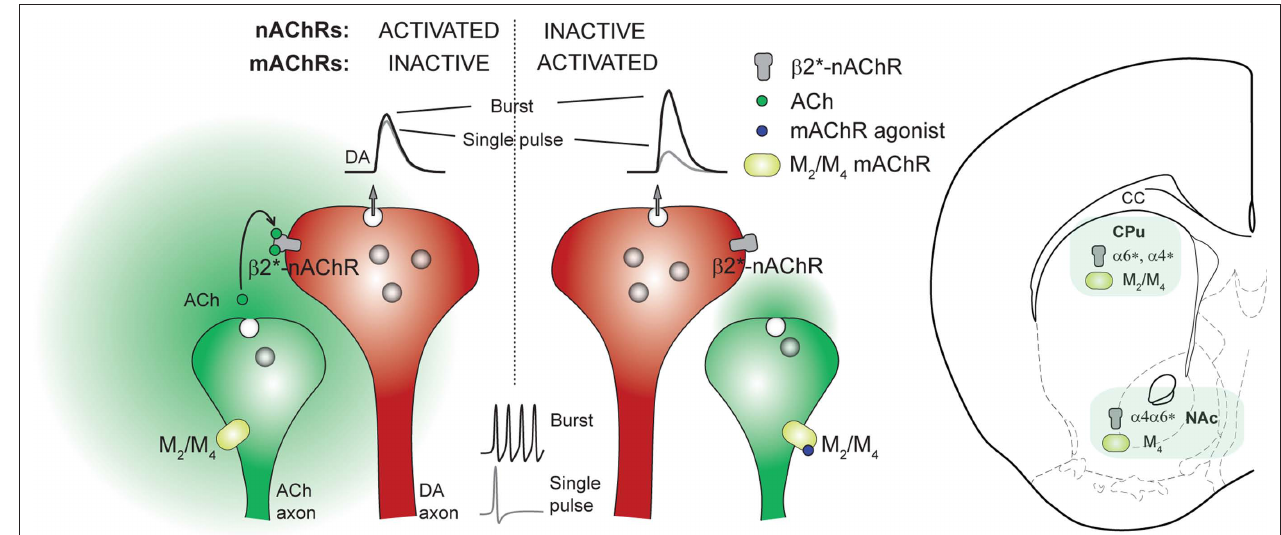
axon terminals, thereby reducing DA release probability by a single stimulus, relieving short-term depression and increasing the relative probability of release at subsequent action potentials. After reduction of ACh tone at β 2*-nAChRs by activation of mAChR autoreceptors on ChIs, or blockade/desensitization of nAChRs, DA release becomes more sensitive to frequency of presynaptic activity (see Rice and Cragg, 2004; Exley and Cragg, 2008). Right, mAChR subtypes and nAChR subunits that regulate DA availability differ between dorsal and ventral striatal subterritories. In dorsal striatum (CPu), M , and M4 2 populations of mAChRs, and α 6*- and α 4*-nAChRs appear to modulate DA release. In ventral striatum (NAc), only M mAChRs and α 4 α 6*-nAChRs appear 4 to modulate DA